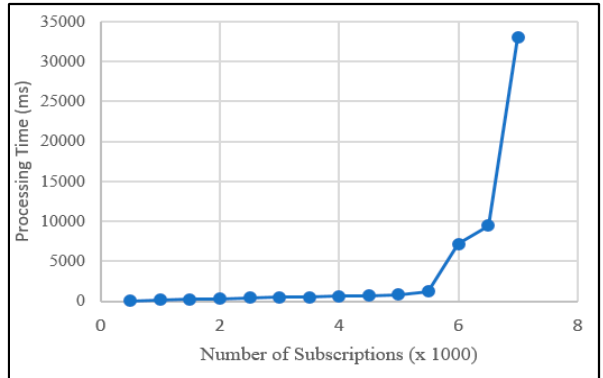
Figure 31. Processing time vs. number of subscriptions.